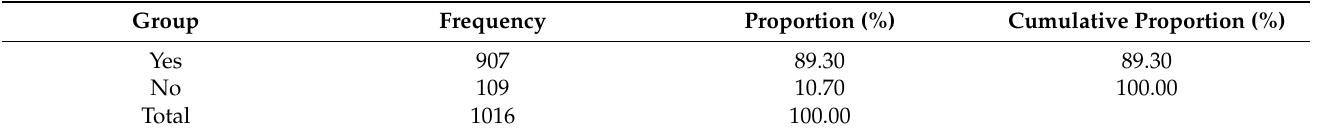
Table 7. Details of students’ choice on the question “I think it is helpful for me to use AI to learning”.